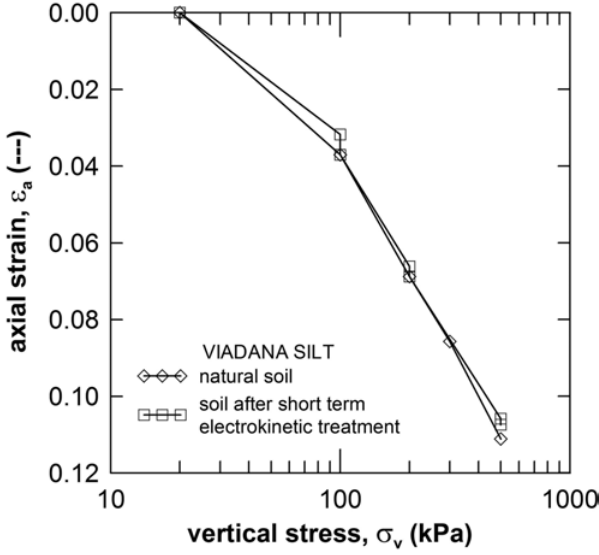
Fig. 1 – One-dimensional compression curves for natural and treated